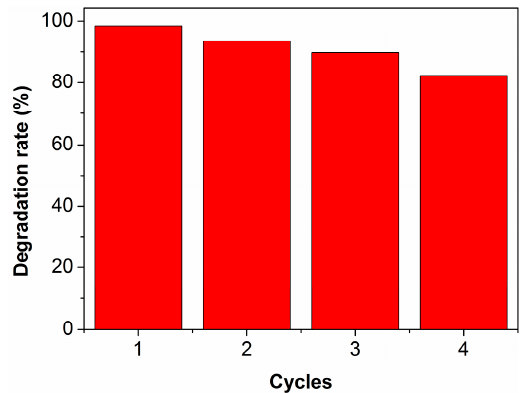
Figure 8. The photocatalytic stability of the chlorella/TiO 2 composite towards the degradation of RhB. Zhang et al. synthesized spirulina/TiO 2 composite to degrade methyl orange (MO) under visible- light irradiation [12]. They obtained a similar k value to ours for the composite, however, they have not compared P25 with the as-prepared composite, and the stability of the composite has not been determined. Our results confirm that the algae, such as spirulina and chlorella, can be used as an